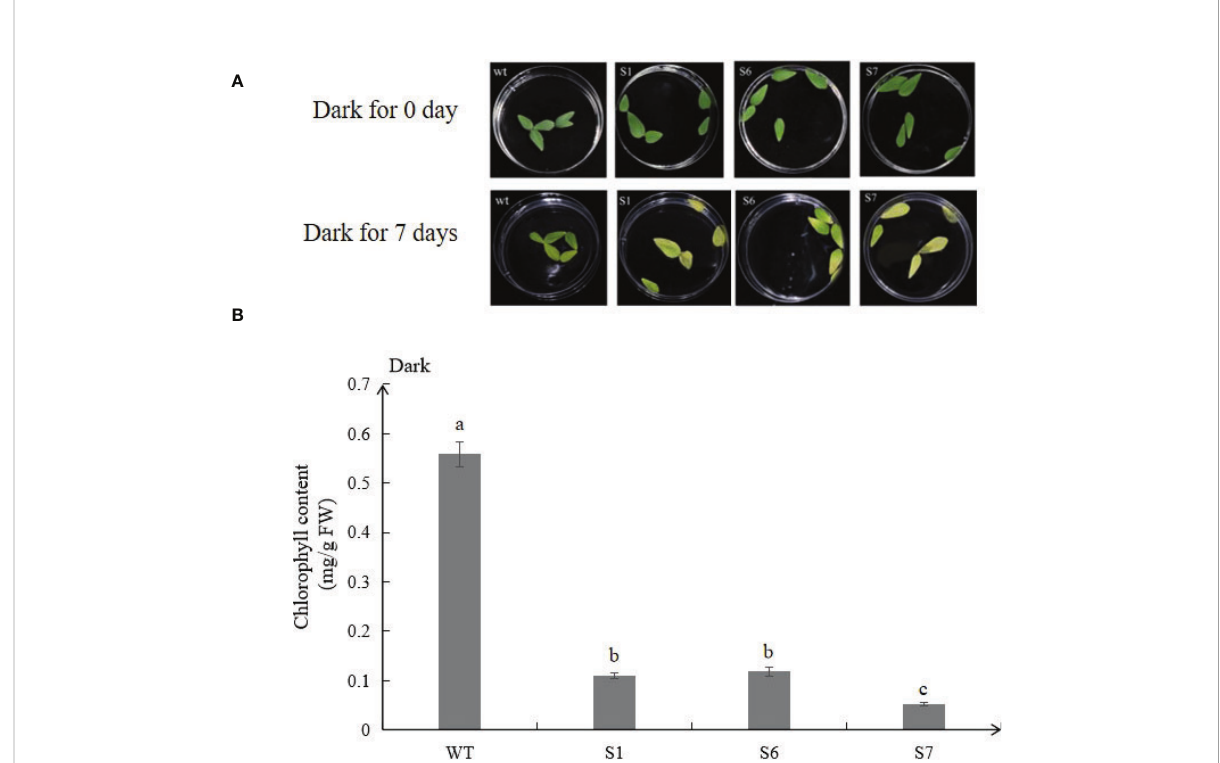
FIGURE 4 MsSAG113 is involved in dark-induced leaf senescence. Phenotypic analysis of 2 month-old wild type and transgenic isolated leaves after dark treatment (A) . Chlorophyll contents of leaves under dark treatment (B) . The values are means ± SD (n = 3). In graphs, bars with different lowercase letters indicate signi fi cant difference at